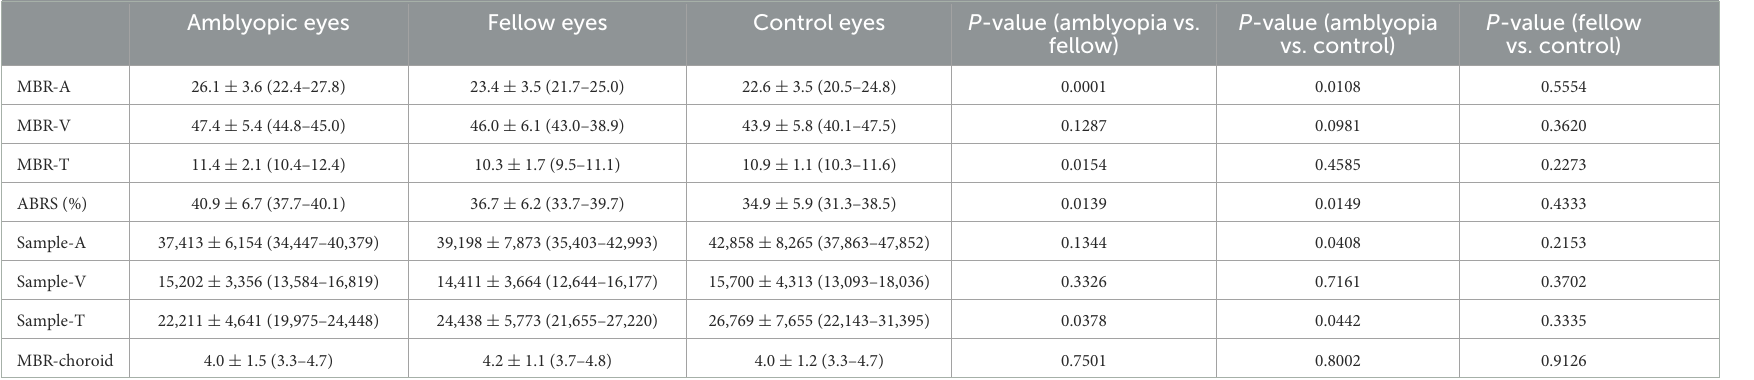
TABLE 3 Comparison of the MBR, ARBS, and sample size among the amblyopic, fellow, and control